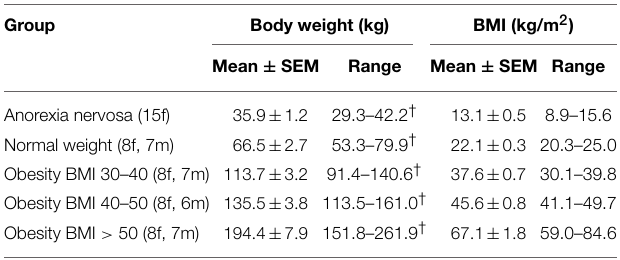
TABLE 1 | Anthropometric characteristics of patient population with broad range of body mass index. Group Body weight (kg) BMI (kg/m 2 ) Mean ± SEM